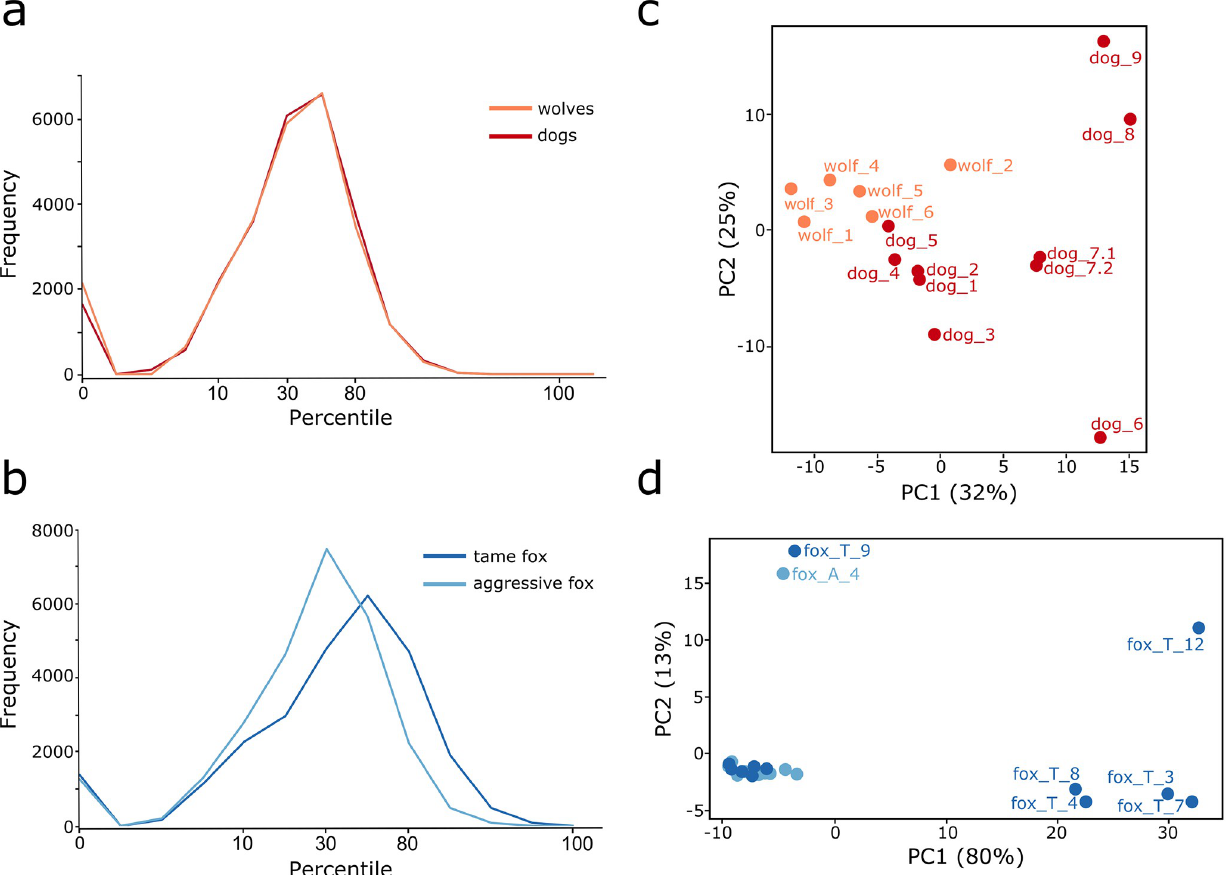
Fig 3. Characterization of intra-condition variation. Percentile range of intra-condition variation scores (x-axis) observed prior to filtering, across both case studies, a) wolves (orange) and dogs (red); b) tame (dark blue) and aggressive (light blue) foxes. PCA plots based on normalized non-filtered count data of the individual datasets comparing c) wolf and dog, and d) tame and aggressive fox. In the latter only individual samples that were positioned within a distant cluster are labelled with the sample ID.